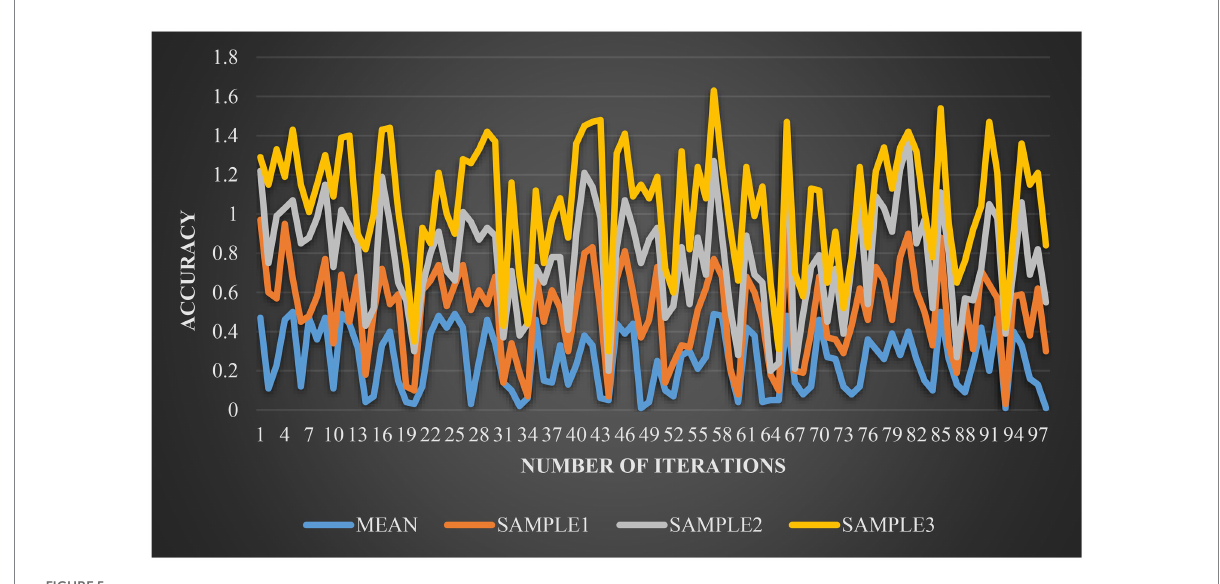
FIGURE 5 Accuracy results of the model during training period